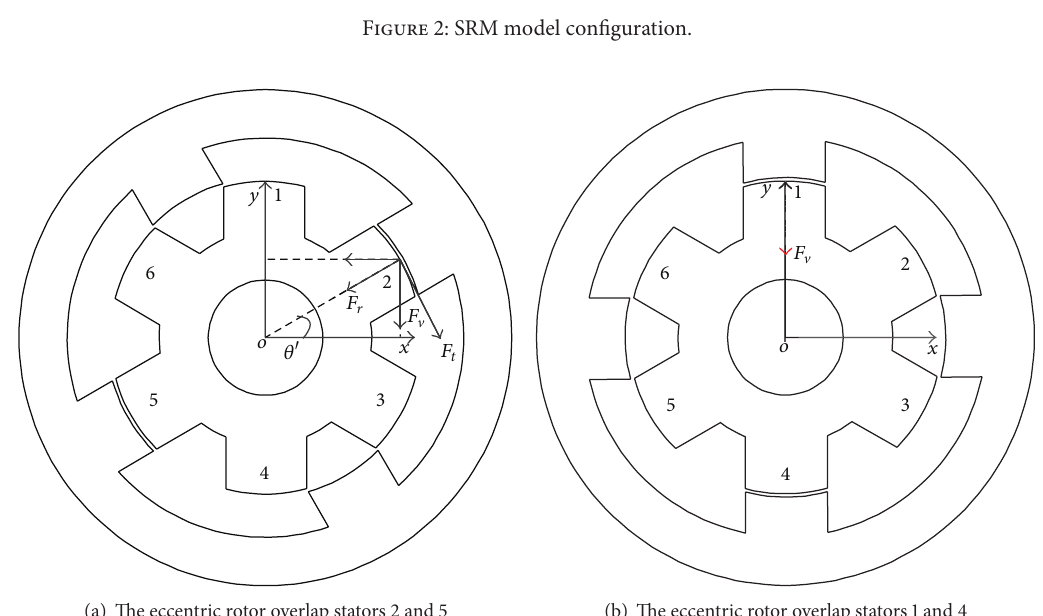
Figure 3: SRM vertical